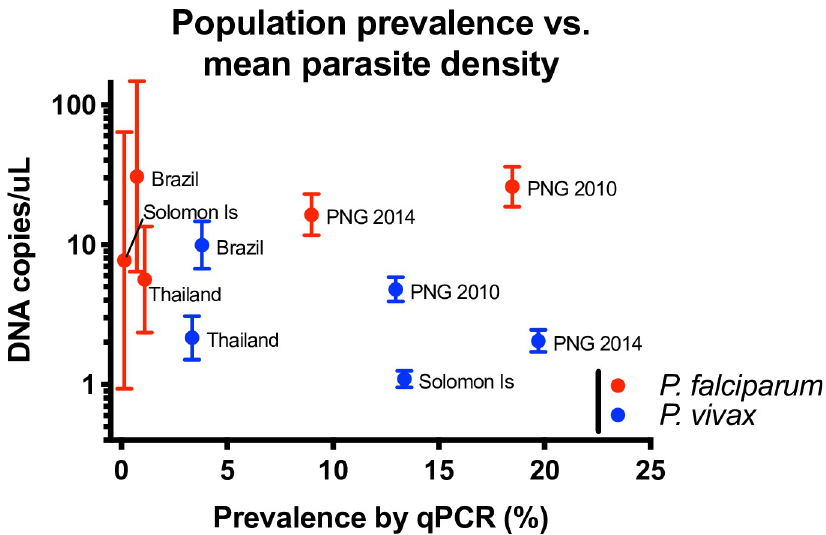
Fig 1. Parasite prevalence and mean parasite density by qPCR in five cross-sectional surveys. Error bars represent 95% confidence intervals.